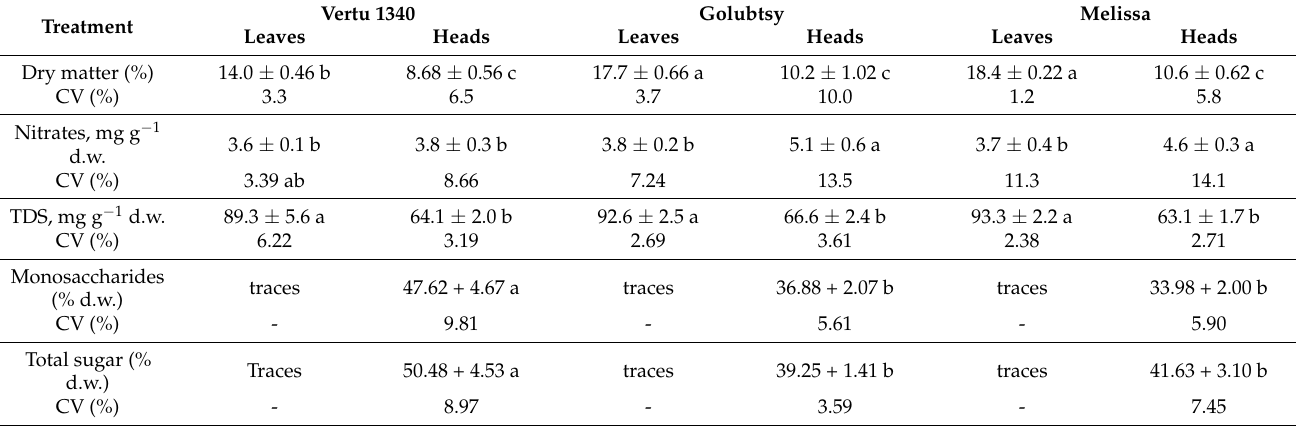
Table 6. Mean values of dry matter, nitrates, total dissolved solids (TDS), and carbohydrates in Savoy cabbage plants of control and fortified with Se under Chlorella